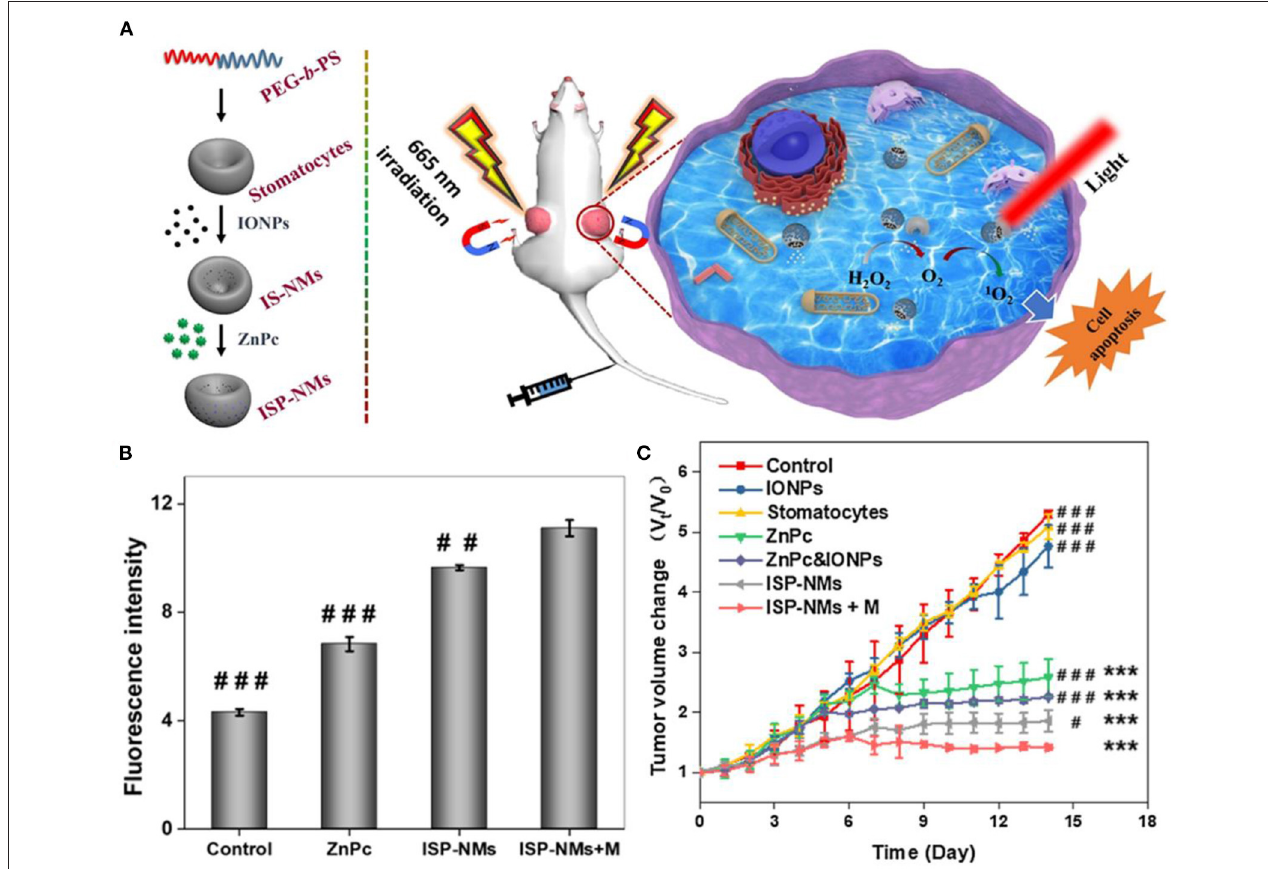
FIGURE 12 | (A) Schematic diagram of ISP-NMs and application for cancer treatment. (B) Fluorescent intensity of cancer cells after treatment. (C) Tumor volume changes during 14 days. * P < 0.05. ** P < 0.01. *** P < 0.001 drugs treated groups versus one of control; # P < 0.05, ## P < 0.01, ### P < 0.001 other drugs treated groups versus the group of ISP-NMs + M. Reproduced, with permission, from Zhang et al. (2020a). Copyright 2020, Elsevier.